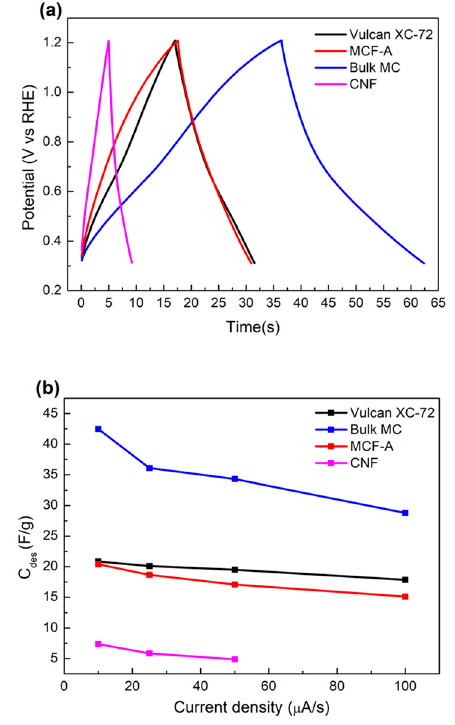
Figure 6. Charge and discharge (CDC) responses of voltage under application of 25 μ A ( a ) and discharge-specific capacitance under different discharging current densities ( b ) for different carbon materials obtained in N 2 -saturated HClO 4 .